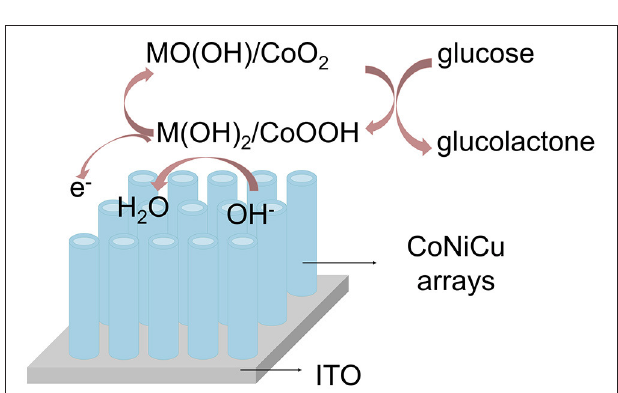
FIGURE 5 | Schematic representation of the glucose electrocatalytic reaction on CoNiCu nanotubes